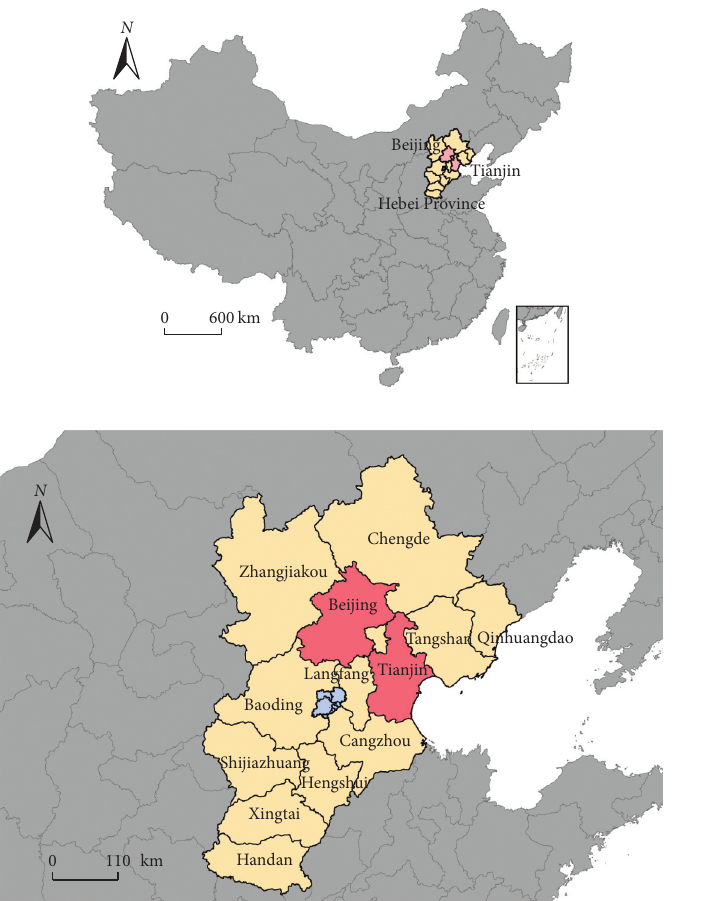
Figure 2: Study area: Xiong’an,